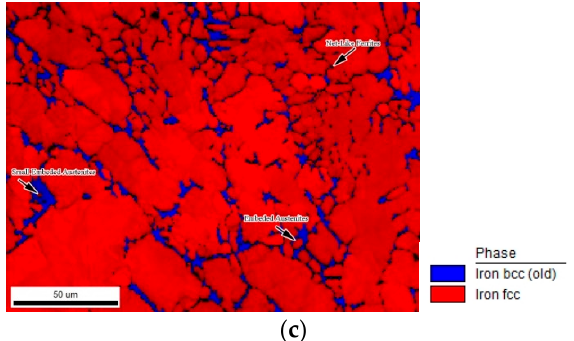
Figure 5. The OM observations and EDS mapping of HAZ: ( a ) the OM micrograph of the GTAW weldment, ( b ) the OM micrograph of the GTAW+EMS weldment, and ( c ) the EBSD analysis of HAZ in the GTAW weldment.